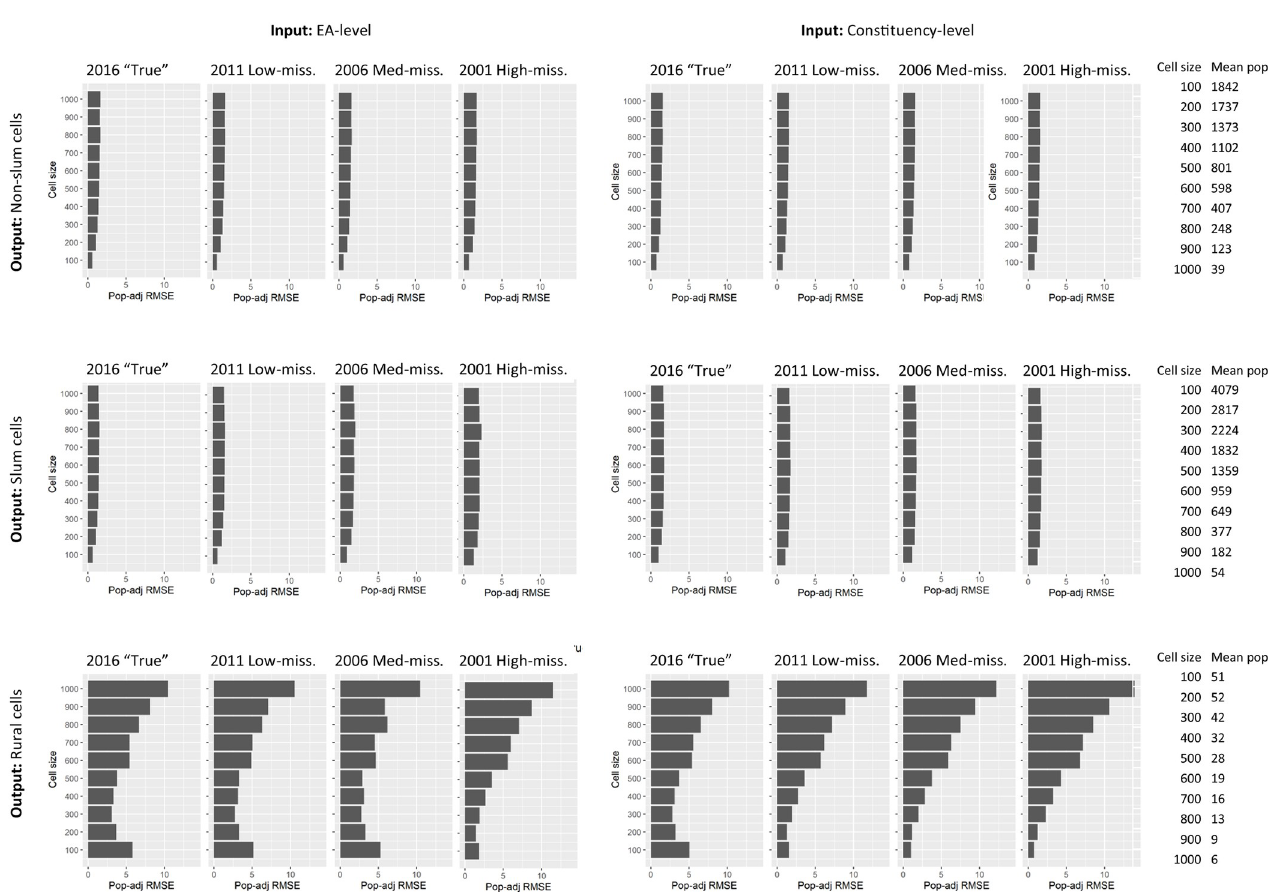
Fig 6. Population-adjusted root mean square error (RMSE) according to input population aggregation, a selection of scenarios, and cell size.